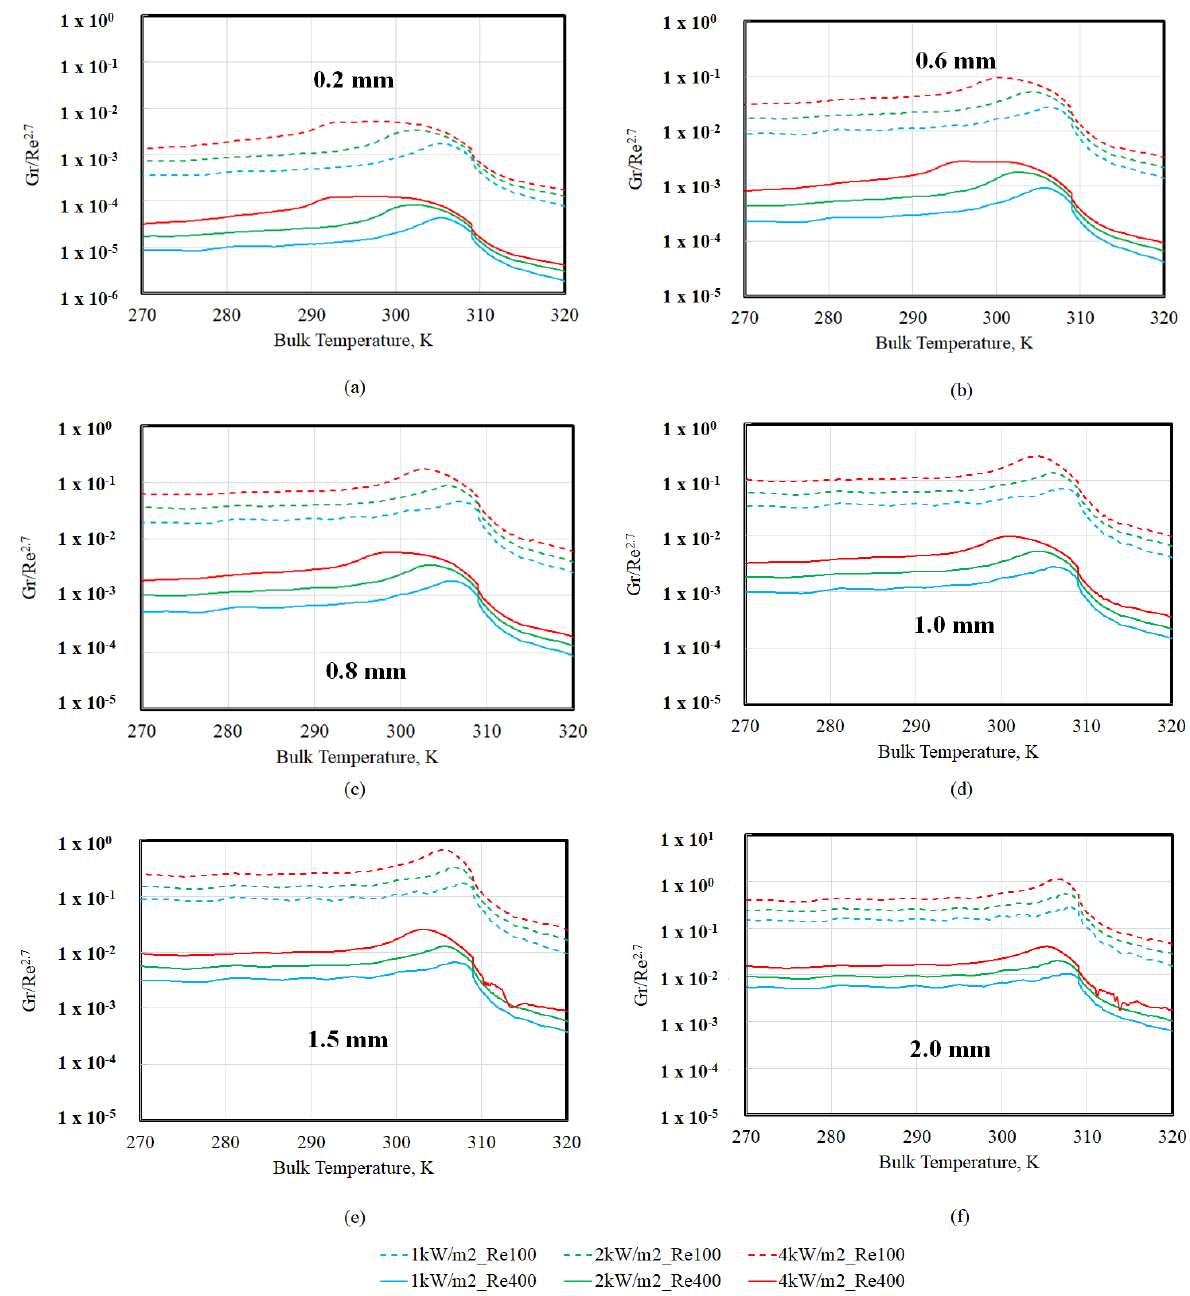
Figure 6. Gr/Re 2.7 versus bulk temperature (T BULK ) at different tube diameters: ( a ) 0.2 mm; ( b ) 0.6 mm; ( c ) 0.8 mm; ( d ) 1.0 mm; ( e ) 1.5 mm; ( f ) 2 mm.